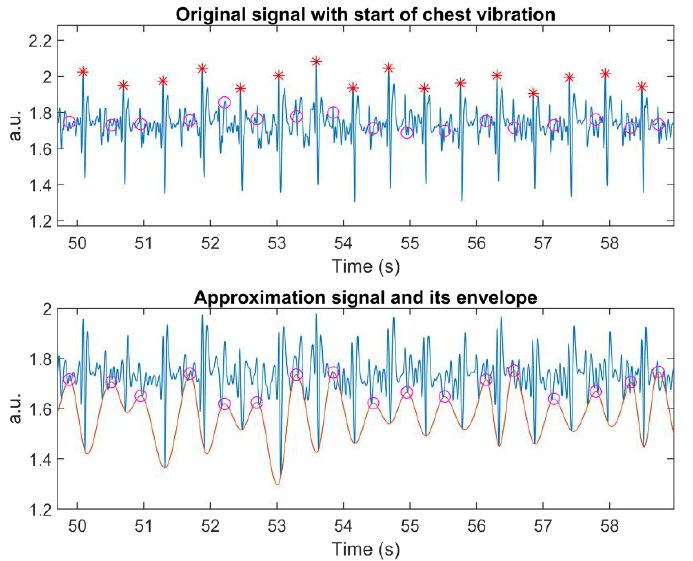
Figure 7. Result from Slice and Detect . Wavelet transform guides the determination of boundaries between individual chest vibrations by providing a peak from the envelope of the Approximation signal (o). The starting points were used to search for corresponding peaks in the enhanced signal, shown as asterisks (*) on top figure.